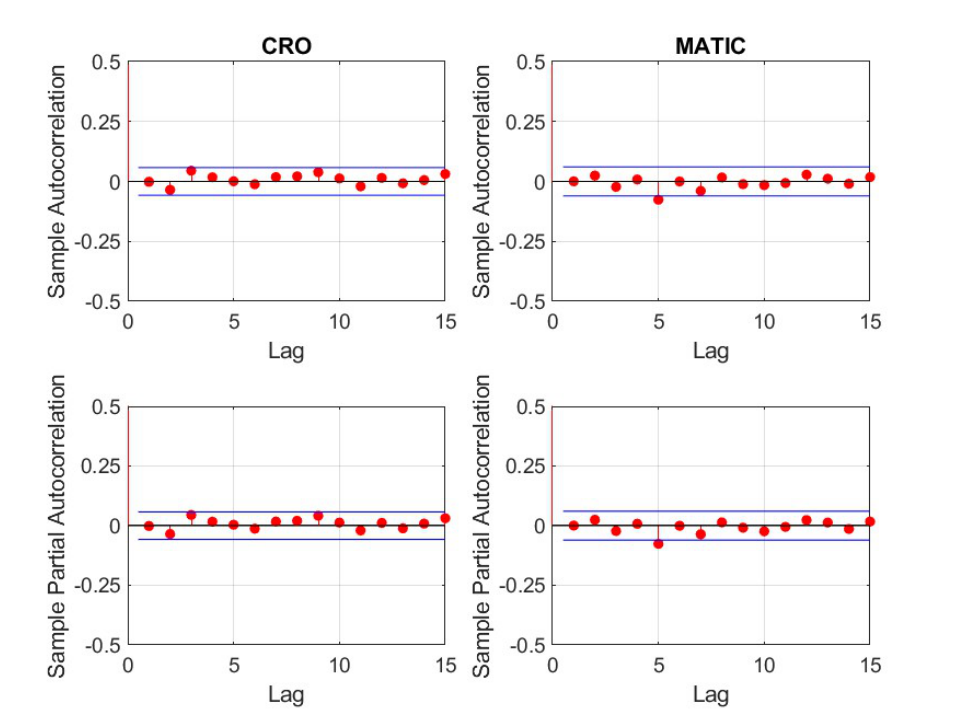
Figure A14. CRO’s and MATIC’s residuals’